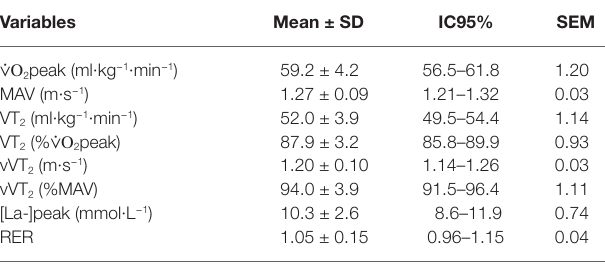
TABLE 2 | Measurements (mean ± SD) during the incremental step test for the entire groups of participants ( N = 12).